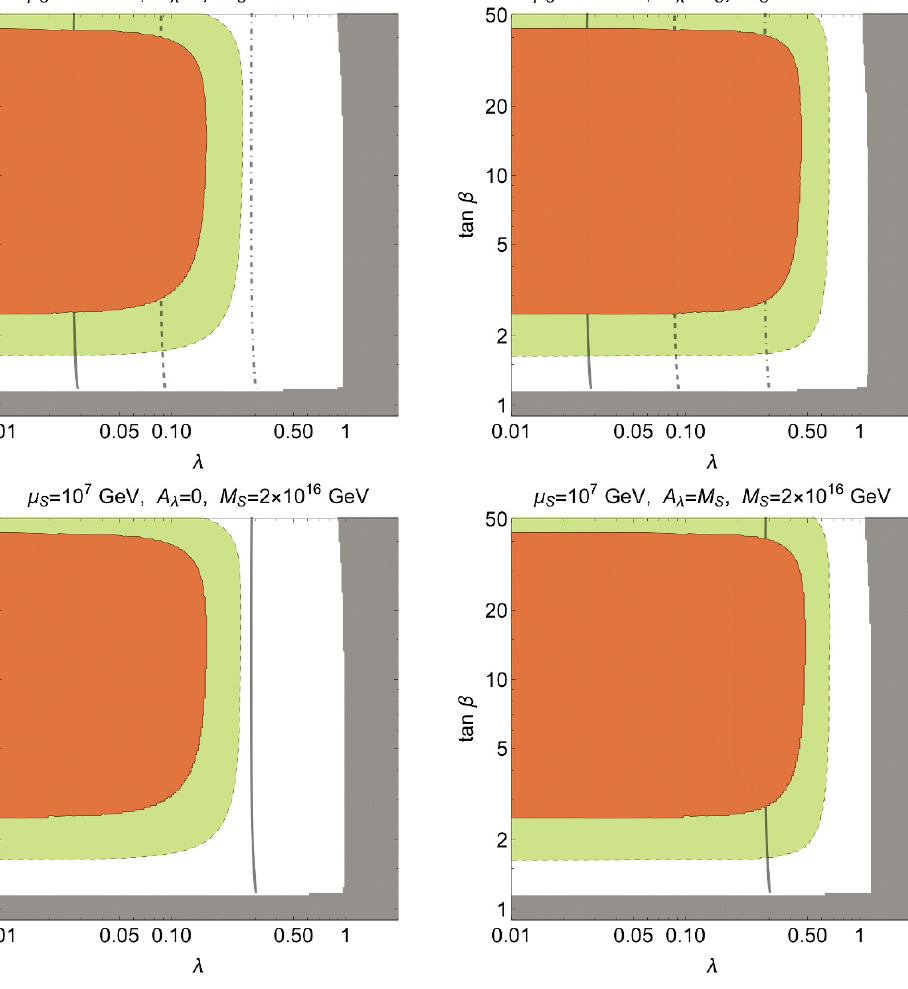
Figure 3 . Same as in (cid:12)gure 2 but for M